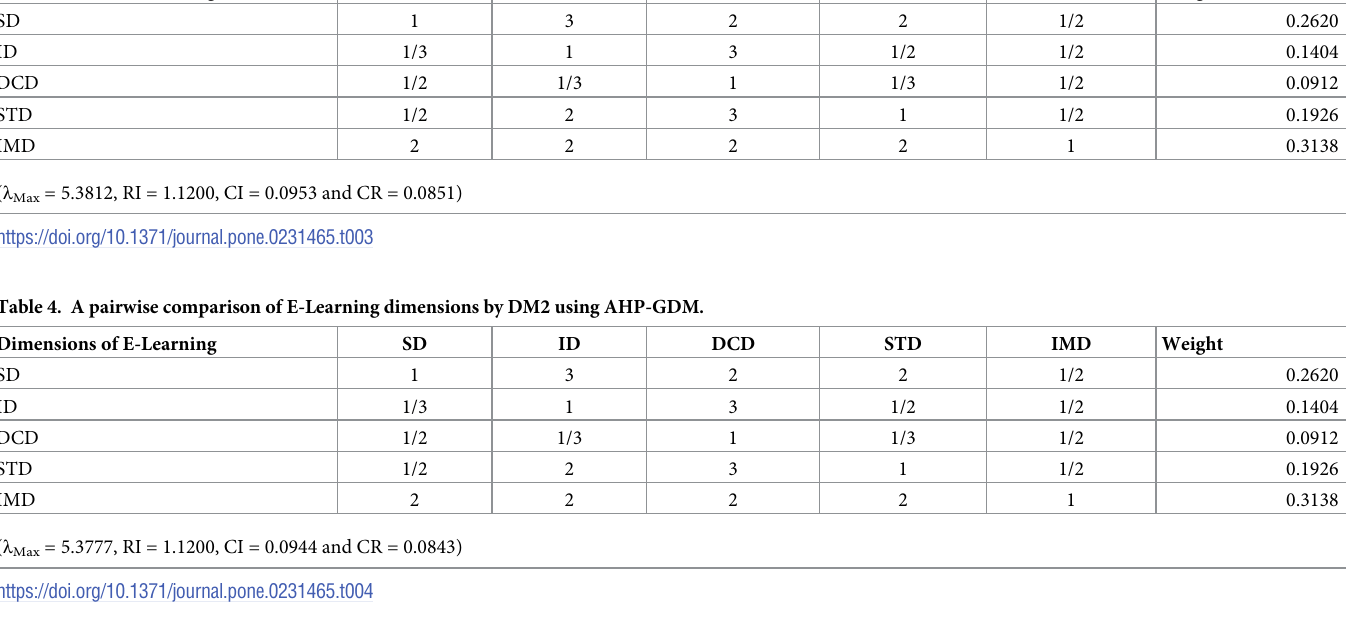
Table 3. A pairwise comparison of E-Learning dimensions by DM1 using AHP-GDM. Dimensions of E-Learning